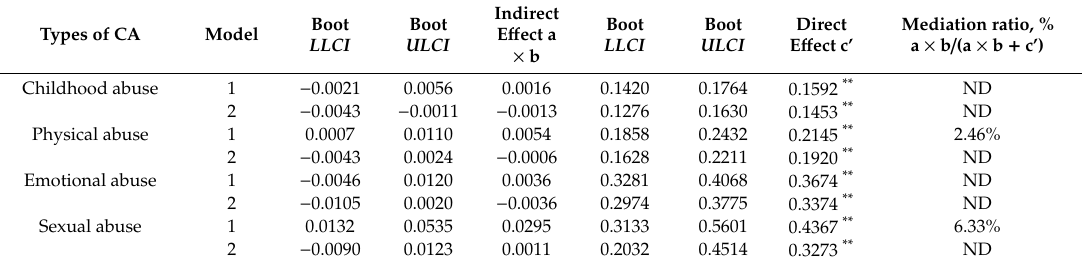
Table 5. Mediation e ff ects of social support between CA and NSSI in non-only